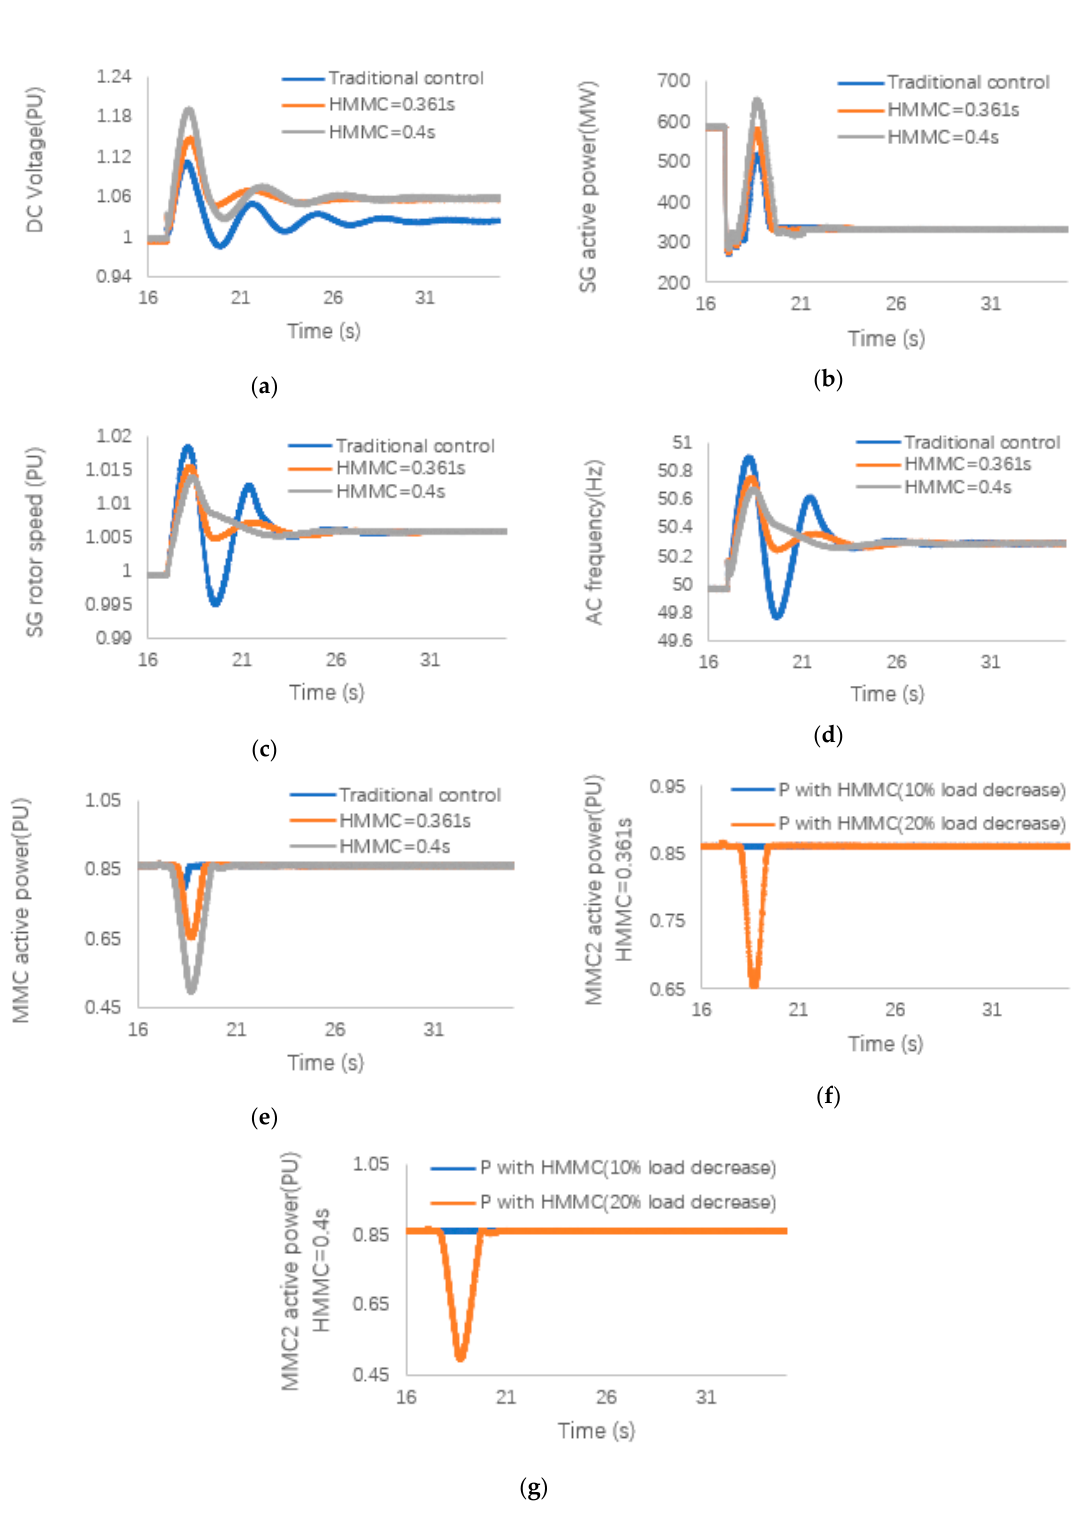
Figure 8. ESCR is 1.7 for 20% load decrease: ( a ) DC voltage; ( b ) SG active power; ( c ) SG rotor speed; ( d ) AC system frequency; ( e ) MMC active power; ( f ) MMC2 active power with HMMC = 0.361 s; ( g ) MMC active power with HMMC = 0.4